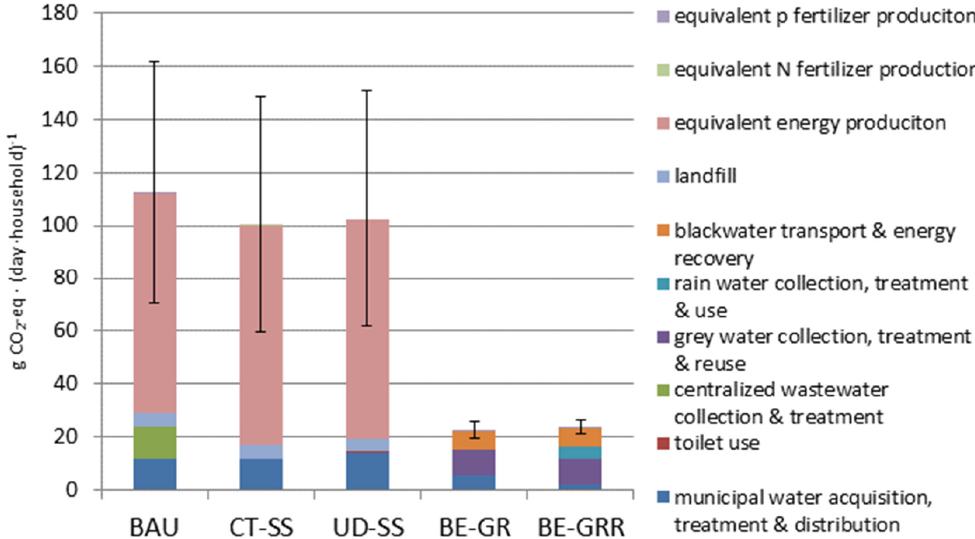
Figure 3. Life cycle global warming potentials of water systems, g CO 2 -eq·(day·household) − 1 . The range of variability bar presents the values at fifth and 95th percentiles.